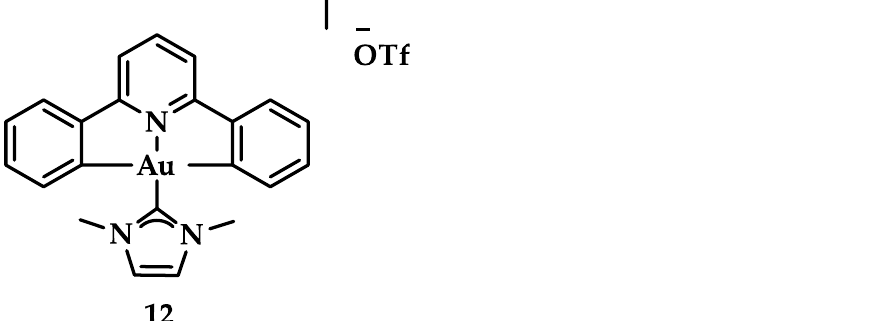
Figure 20. Heterobimetallic ruthenium-gold complexes [Ru(p-cymene)Cl 2 (μ -dppm)Au(NHC)]ClO 4 [147] . Dianionic [C^N^C] 2 − auxiliary NHC ligands were employed in the synthesis of Au(III) complexes by Che et al., displaying a potential anticancer activity in vitro and in vivo. Compounds 14a and 14b (Figure 21) showed promising anticancer activity against hepatocellular carcinoma (HepG2) with IC 50 value 7.9 ± 0.6 μ M and 1.1 ± 0.1 μ M, respec- tively, while 13b displayed cytotoxicity against camptothecin-resistant cells (KB-CPT-100) with an IC 50 value of 12 ± 1.3 μ M; further, 14a displayed low cytotoxicity against the non- cancerous lung fibroblast cells (CCD-19Lu) with a value > 100 μ M [107].